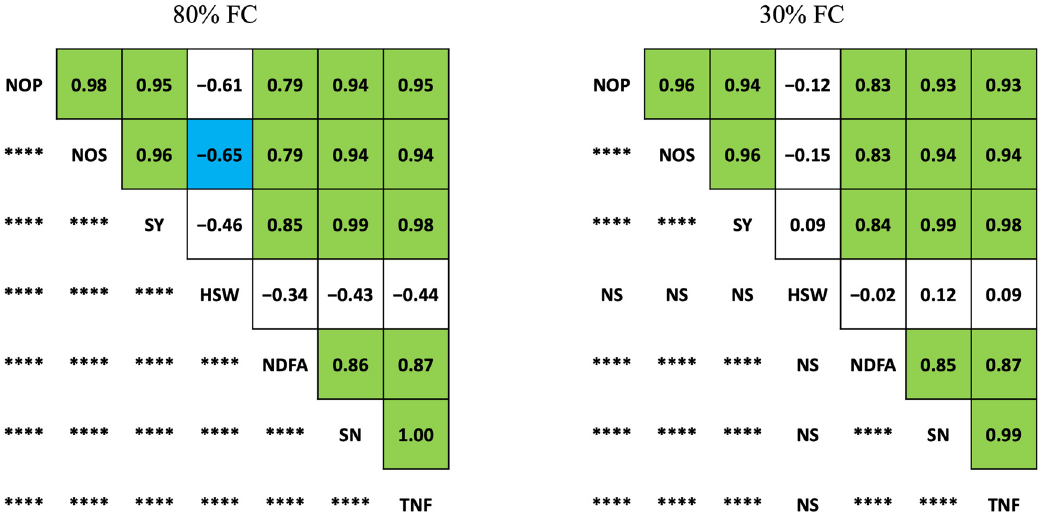
Figure 2. Correlations among yield- and nitrogen fixation-related traits in soybean under drought and well-watered conditions. Numbers above the diagonal correspond to Pearson’s correlation coefficients (r). Green boxes highlight the positive values exceeding 0.65 and blue boxes highlight the negative values exceeding or equal to 0.65 [60]. Below the diagonal show the degree of significance of the corresponding correlations between traits (**** p < 0.0001, and NS: not significant). FC, field capacity; NOP, number of pods; NOS, number of seeds; SY, seed yield; HSW, 100-seed weight; %Ndfa, percentage of nitrogen derived from the atmosphere; SN, seed nitrogen; TNF, total nitrogen fixed.